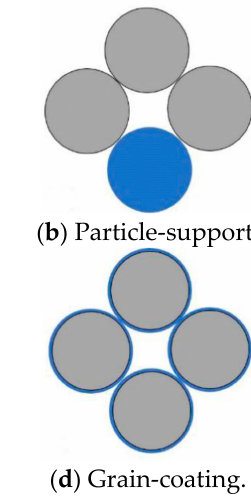
Figure 1. Hydrate occurrence modes of coarse-grained sediments [21].